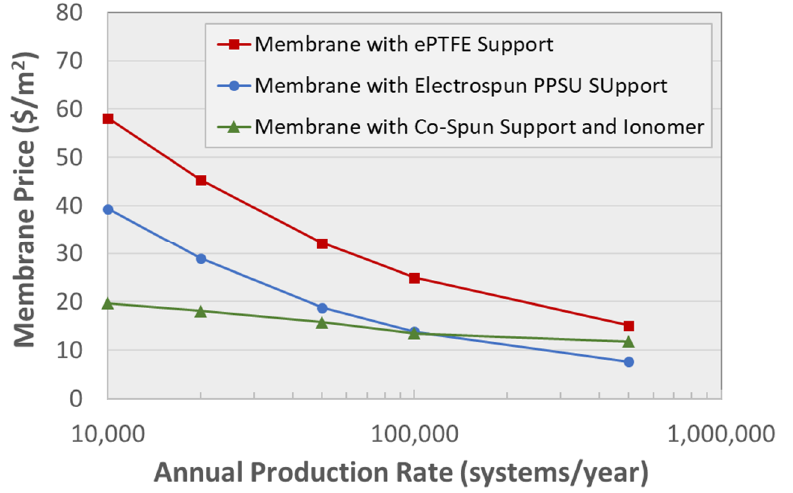
Figure 7. Relationship between composite membranes price and fuel cell stack (system) annual production rate, from an economic study carried out by strategic Analysis, Inc. [88]. All membranes are 14 μm in thickness with 95% Nafion PFSA ionomer. Reproduced with permission from Ref. [88].